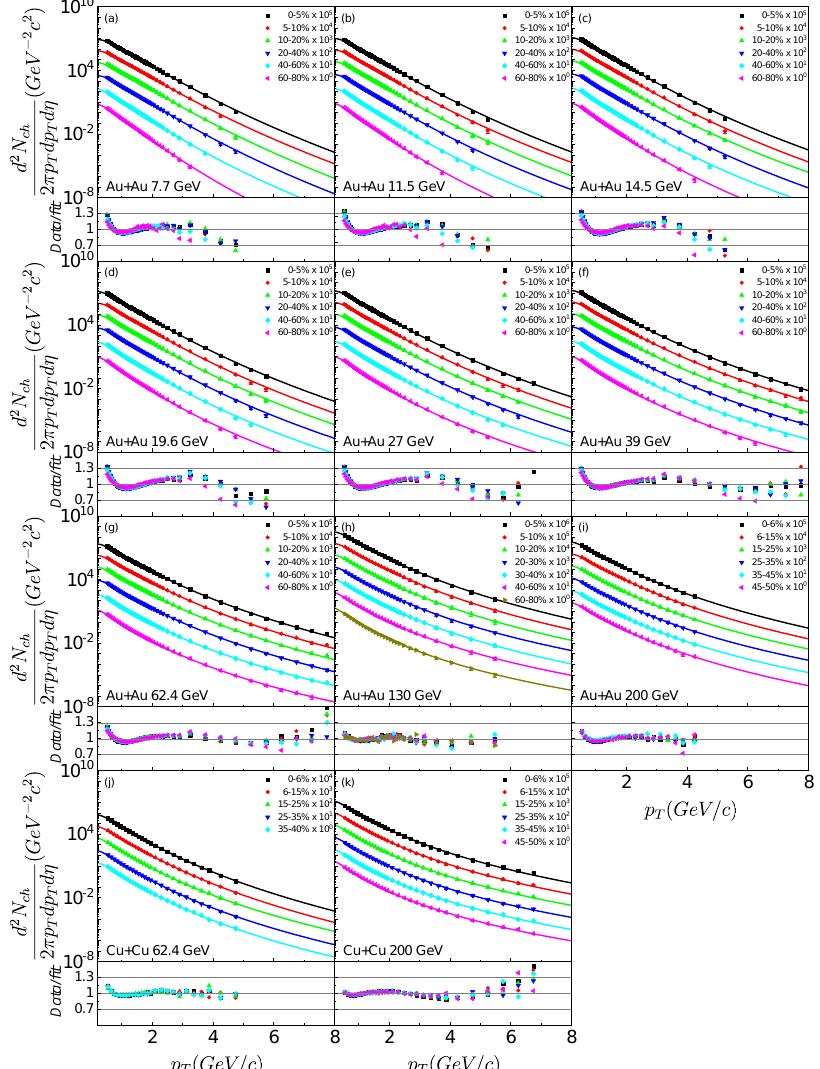
Figure 1. (Color online) The transverse momentum distribution of charged particles produced in √ s NN = 7.7 to 200 GeV and Cu + Cu collisions at Au + Au collisions for energies ranging from √ s NN = 62.4 and 200 GeV at the RHIC. Scale factors are applied for better visibility. The curves are the fit results from Equation (4). The experimental data are taken from Refs. [1–4]. The corresponding ratios of data/fit are also